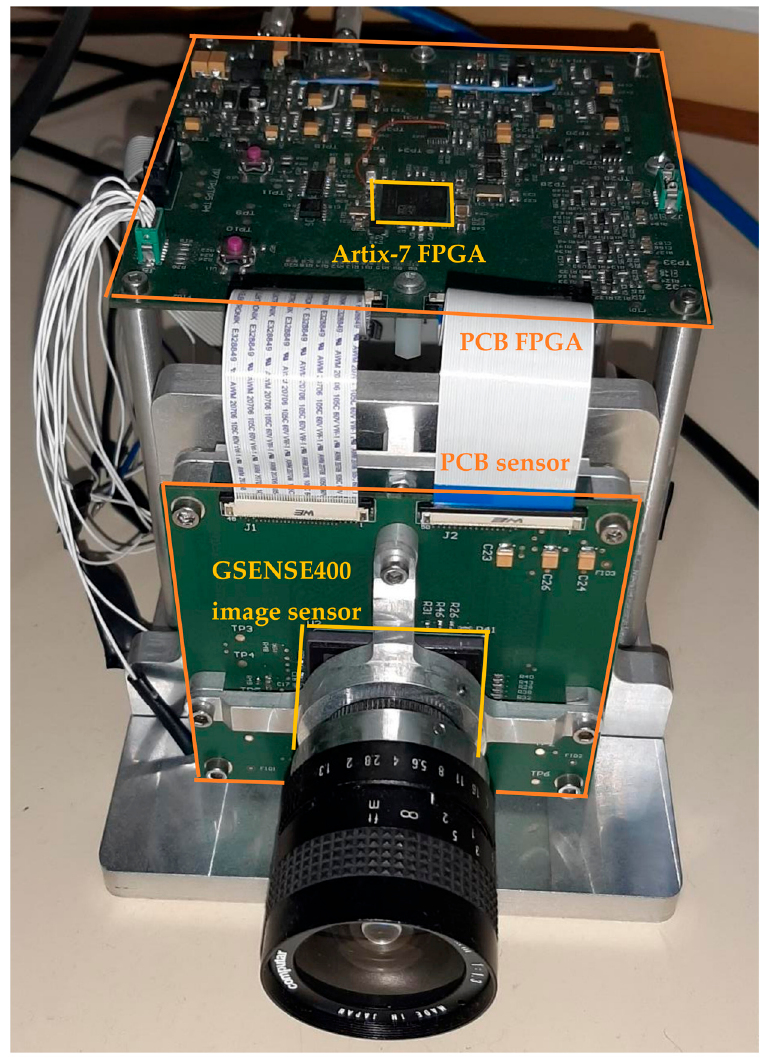
Figure 2. Picture of the first prototype of the TuMag instrument camera.